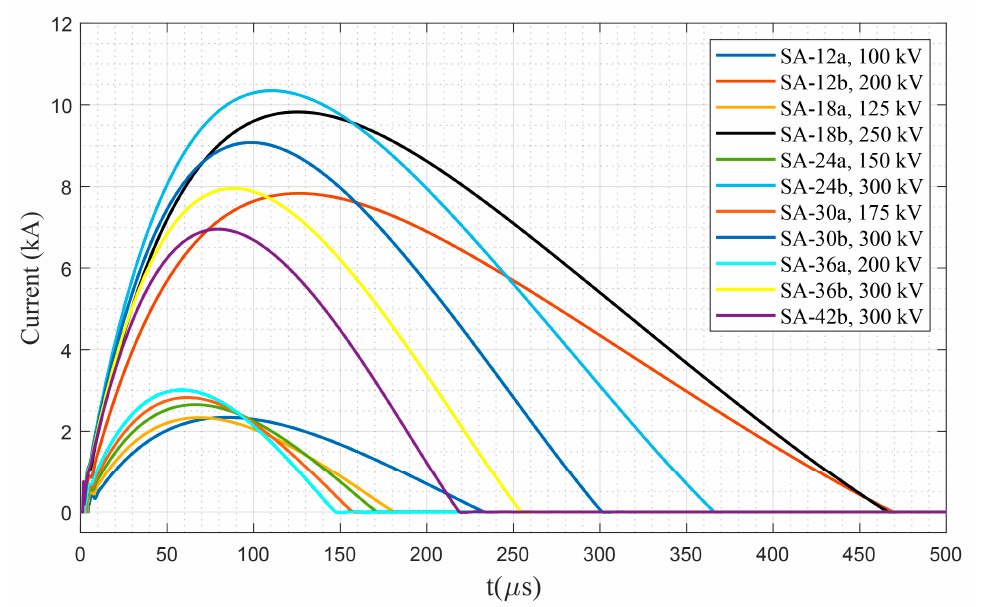
Figure 33. Comparison of the current flow through di ff erent surge arresters against the highest handleable lightning